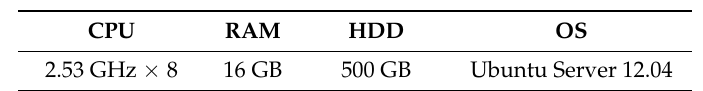
Table 1. Specification of servers.